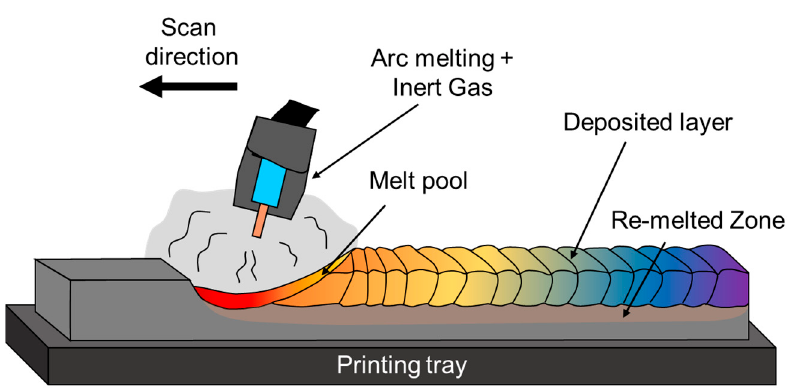
Figure 12. Schematic illustration of wire arc AM (WAAM) process.